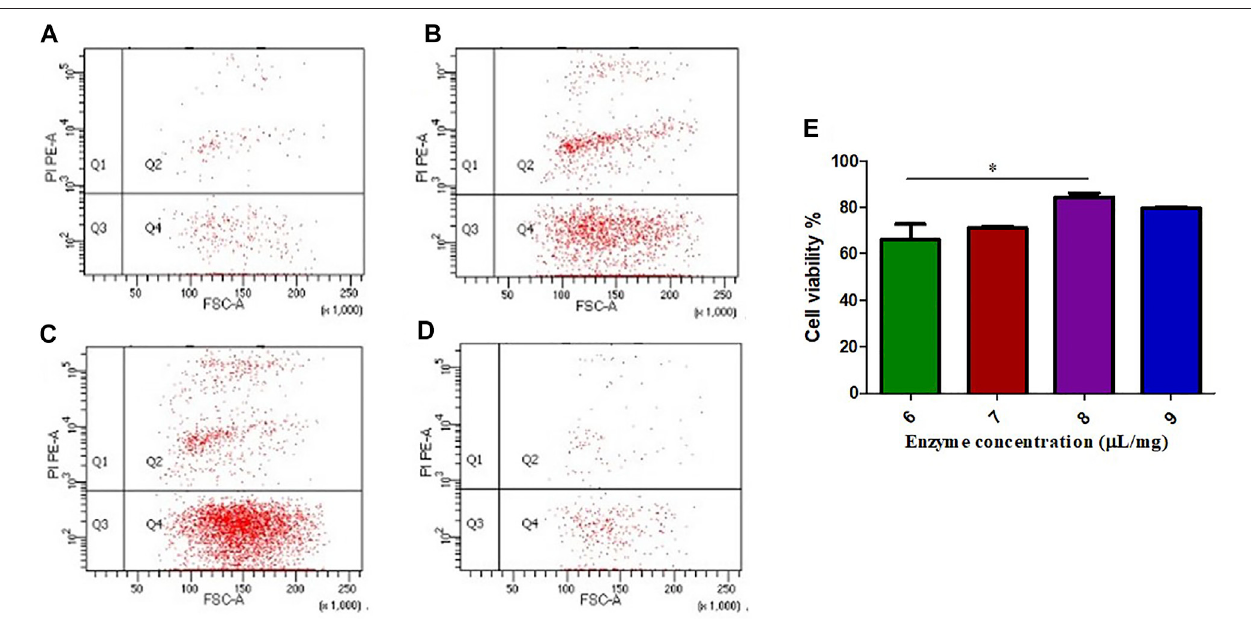
FIGURE 1 | The effect of FCMase enzyme concentrations on cell viability during the preparation of single cell suspension. (A) 6 μ L/mg, (B) 7 μ L/mg, (C) 8 μ L/mg, (D) 9 μ L/mg, of FCMase enzyme. (E) Statistical comparison of the effect of FCMase enzyme concentrations on cell viability. Data are presented as means ± SD; * p value < 0.05.